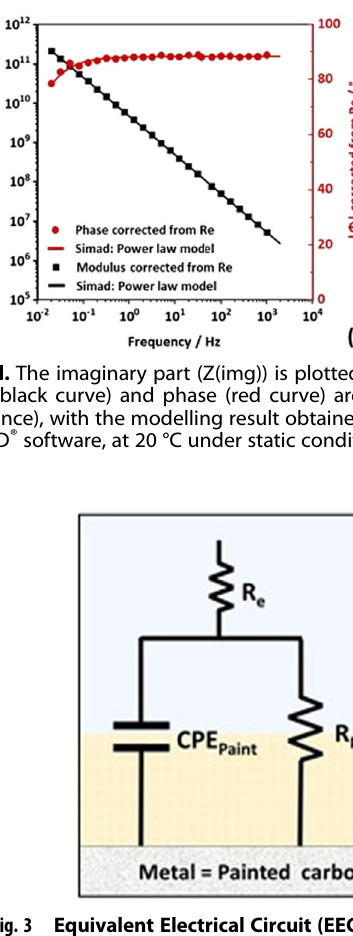
Fig. 3 Equivalent Electrical Circuit (EEC) of a freshly painted steel/ seawater interface. It illustrates the case of a freshly painted, defect- free sample immersed in seawater after 2 h at OCP (Open Circuit Potential), at 20 °C in static condition and natural